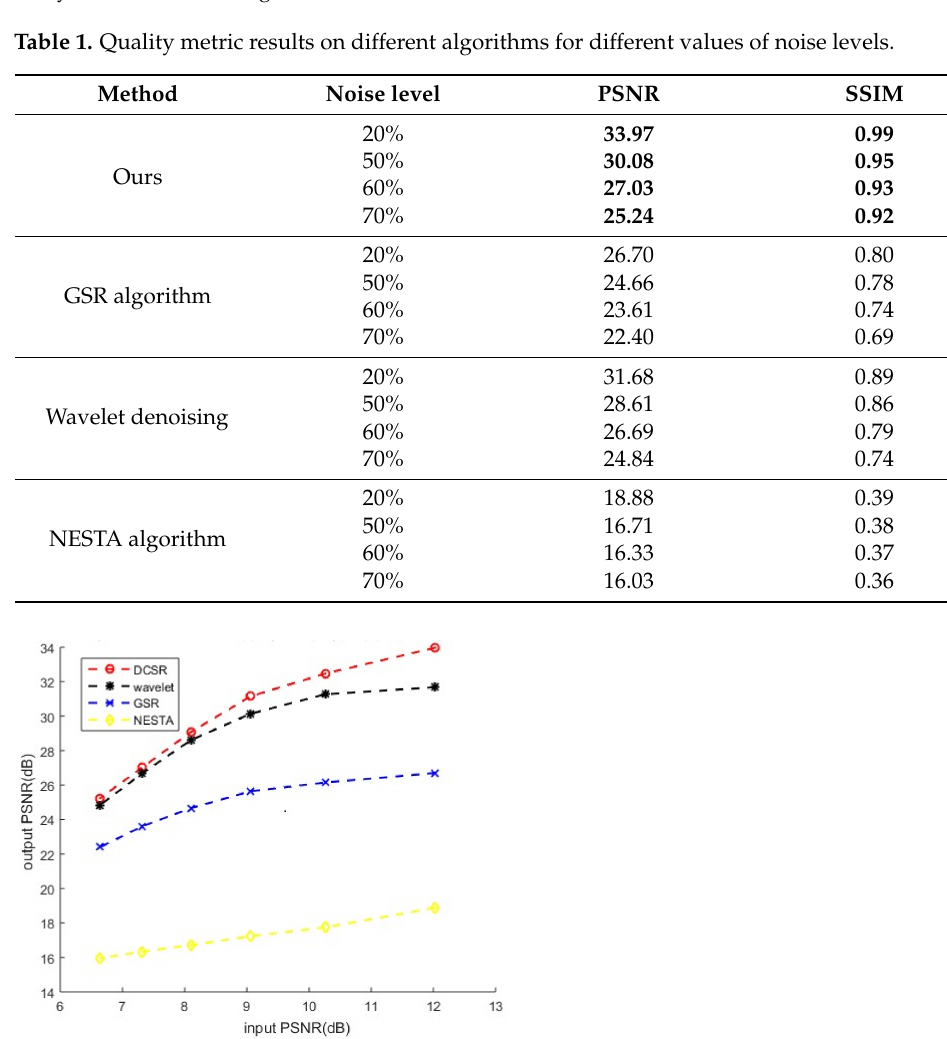
Figure 6. Grayscale image corrupted by salt and pepper noise: performance analysis of four denoising